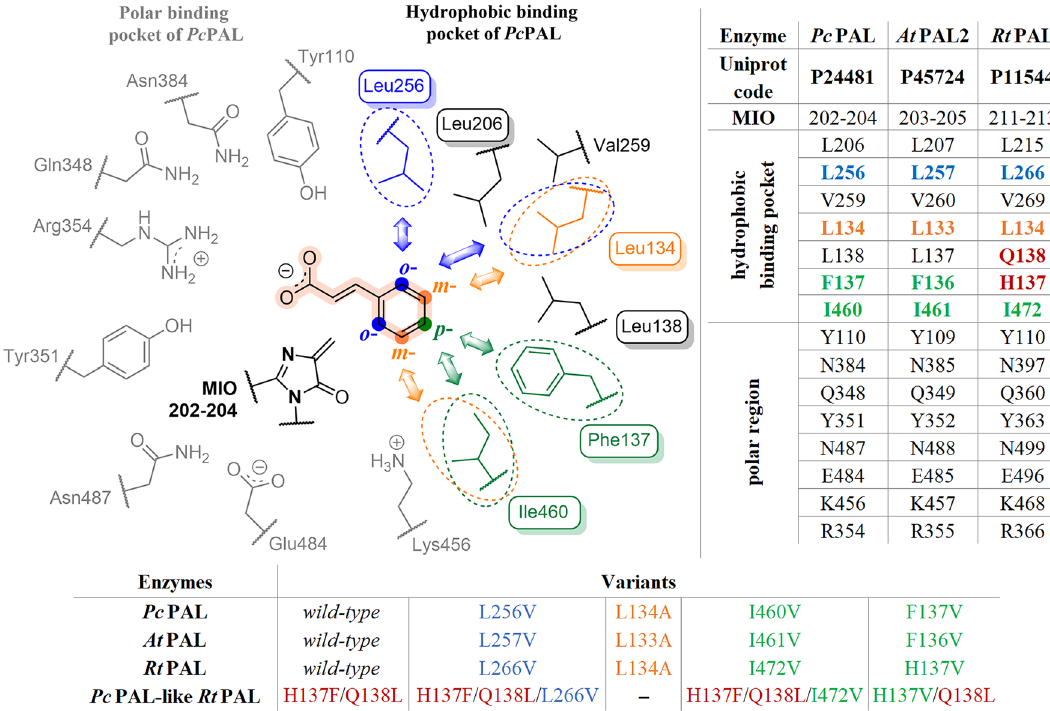
Figure 1. Catalytic site of Pc PAL, with key residues from the hydrophobic substrate-binding region marked based on their proximity 2 to the differently positioned ( ortho -blue, meta -orange and para- green ) aromatic substituents of the substrates and the homologue active site residues in Rt PAL (P11544) and At PAL (P45724) based on sequence alignments with Pc PAL (P24481) ( right Table ) with colour-marked residues subjected to mutagenesis, generating the focused PAL variant-library ( bottom Table